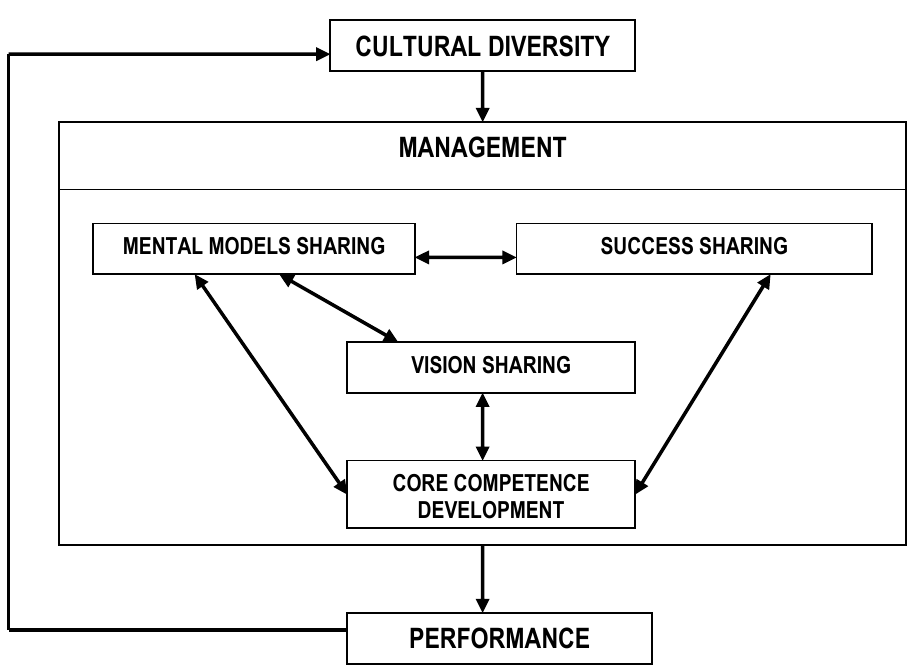
Figure 2: Conceptual framework for effective